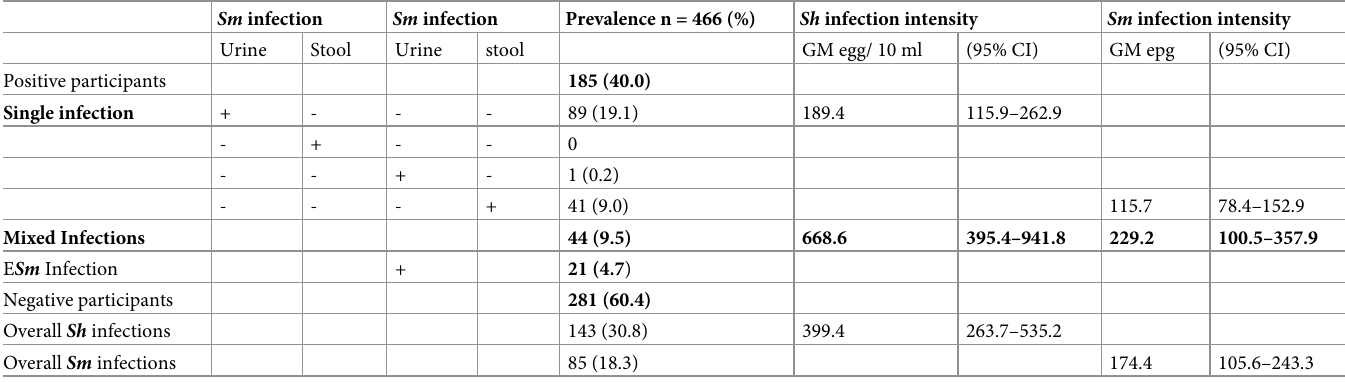
Table 2. Schistosomal infection prevalence and intensities.